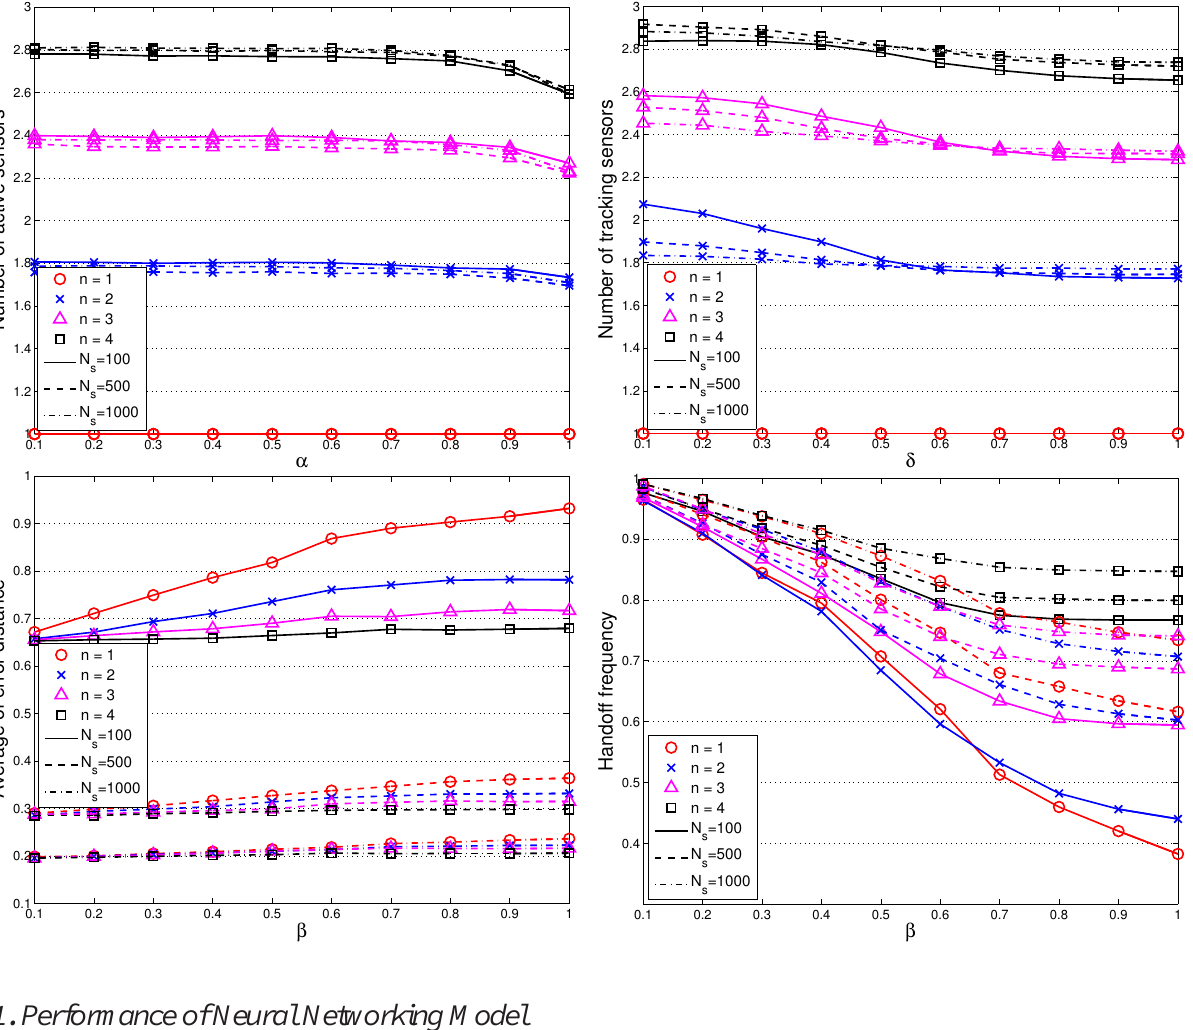
Figure 10. The target localization error with β = δ = 0 . 5 and varying the values of α ( top left ); The target localization error with α = β = 0 . 5 and varying the values of δ ( top right ); The target localization error with α = δ = 0 . 5 and varying the values of β ( bottom left ); The leader handoff frequency with α = δ = 0 . 5 and varying the values of β ( bottom right